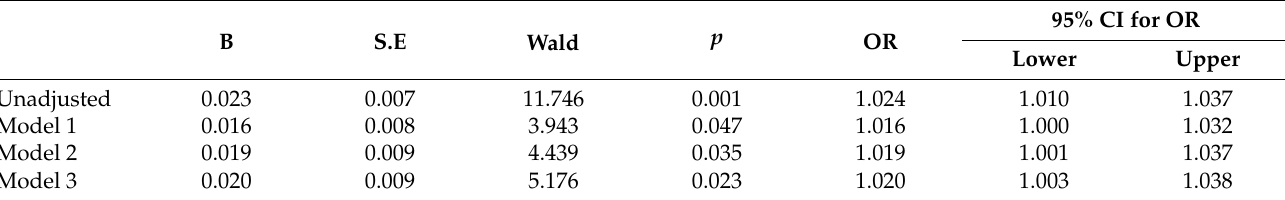
Table 3. Multivariable logistic regression analysis of PP and cognitive decline.